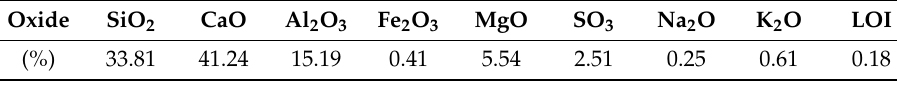
Table 1. Chemical composition of used blast furnace slag.